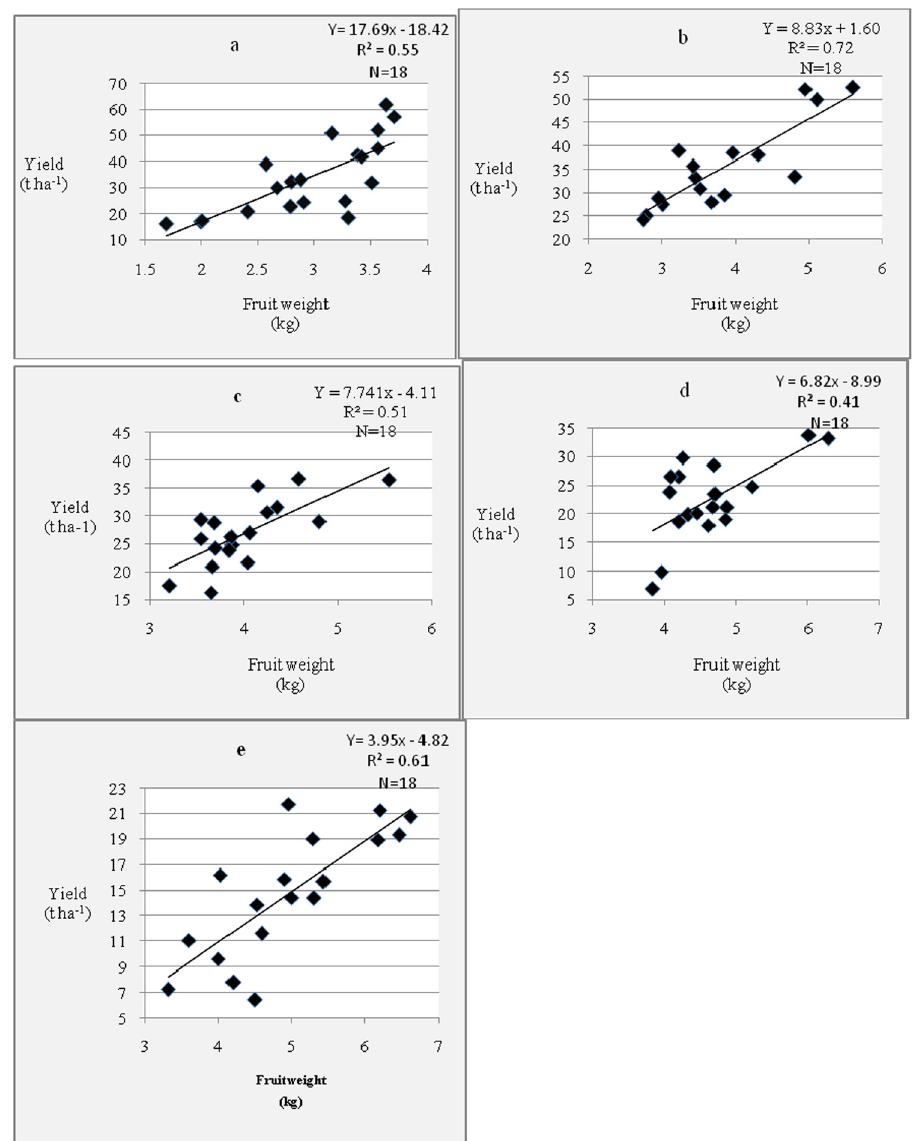
Figure 5: Relationship between fruit yield and weight of Crimson Sweet variety within each plant density: ( a ) 24,690 ha − 1 , ( b ) 13,888 ha − 1 , ( c ) 8,888 ha − 1 , ( d ) 6,172 ha − 1 , and ( e ) 4,535 ha − 1